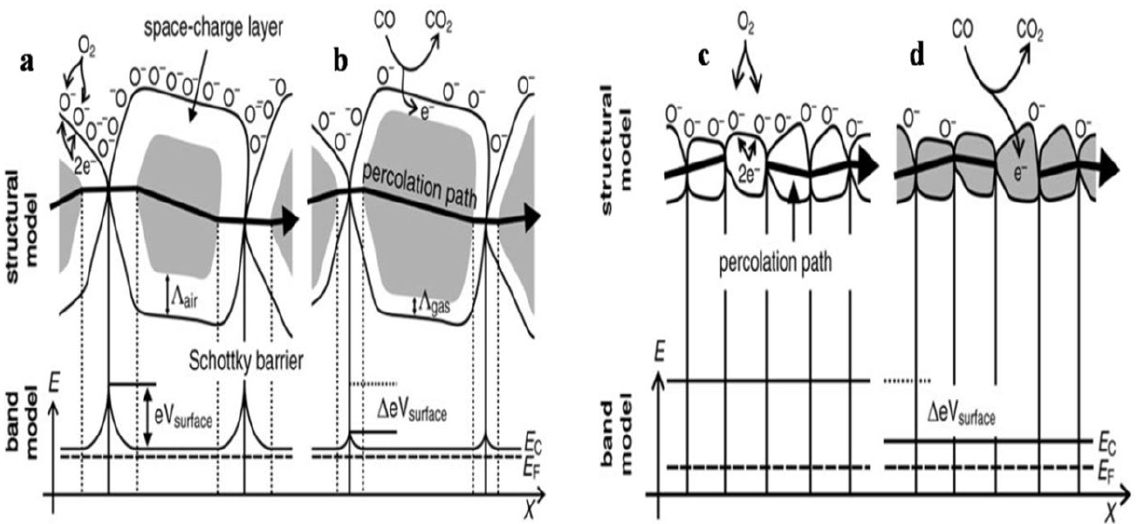
Figure 2. Structural and band model showing the role of intergranular contact regions in determining the conductance over a polycrystalline metal oxide semiconductor: ( a ) initial state and ( b ) effect of CO on Λ air and eV surface for large grains; structural and band model for particles with D <2 Λ air leading to the so-called “flat-band” case: ( c ) the initial state and ( d ) the effect of CO on the position of the conduction band E c (Reprinted with permission from [64] Copyright 2003, Elsevier).